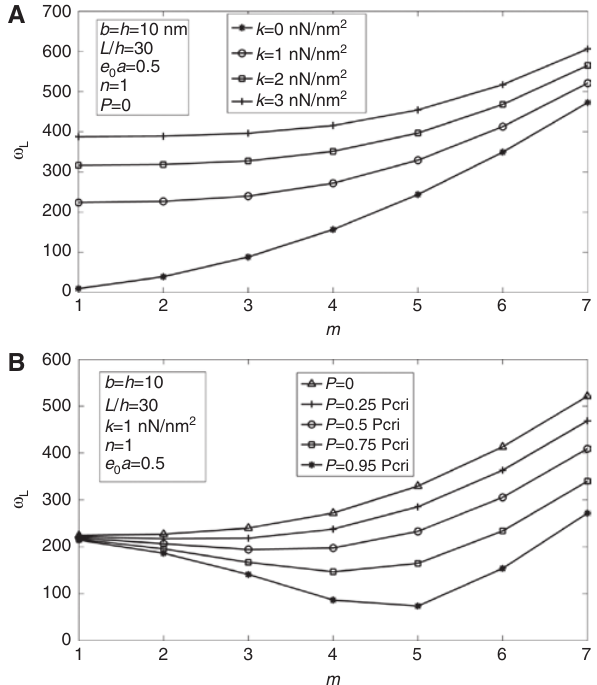
Figure 5: Effect of (A) stiffness of elastic foundation and (B) preaxial compressive force on the natural frequencies of FG nanobeams.